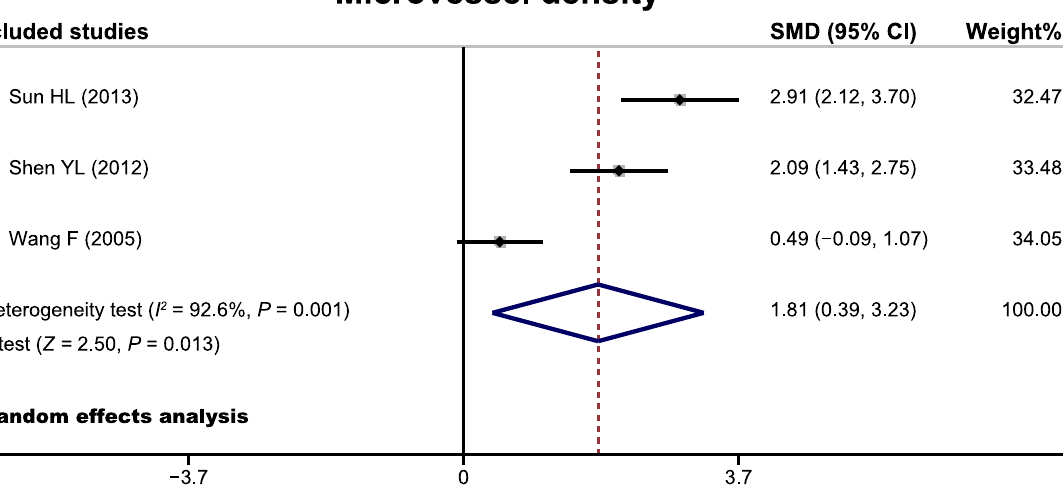
Figure 4. Forest plots for the relationship between PTTG expression and microvessel density of pituitary adenomas.